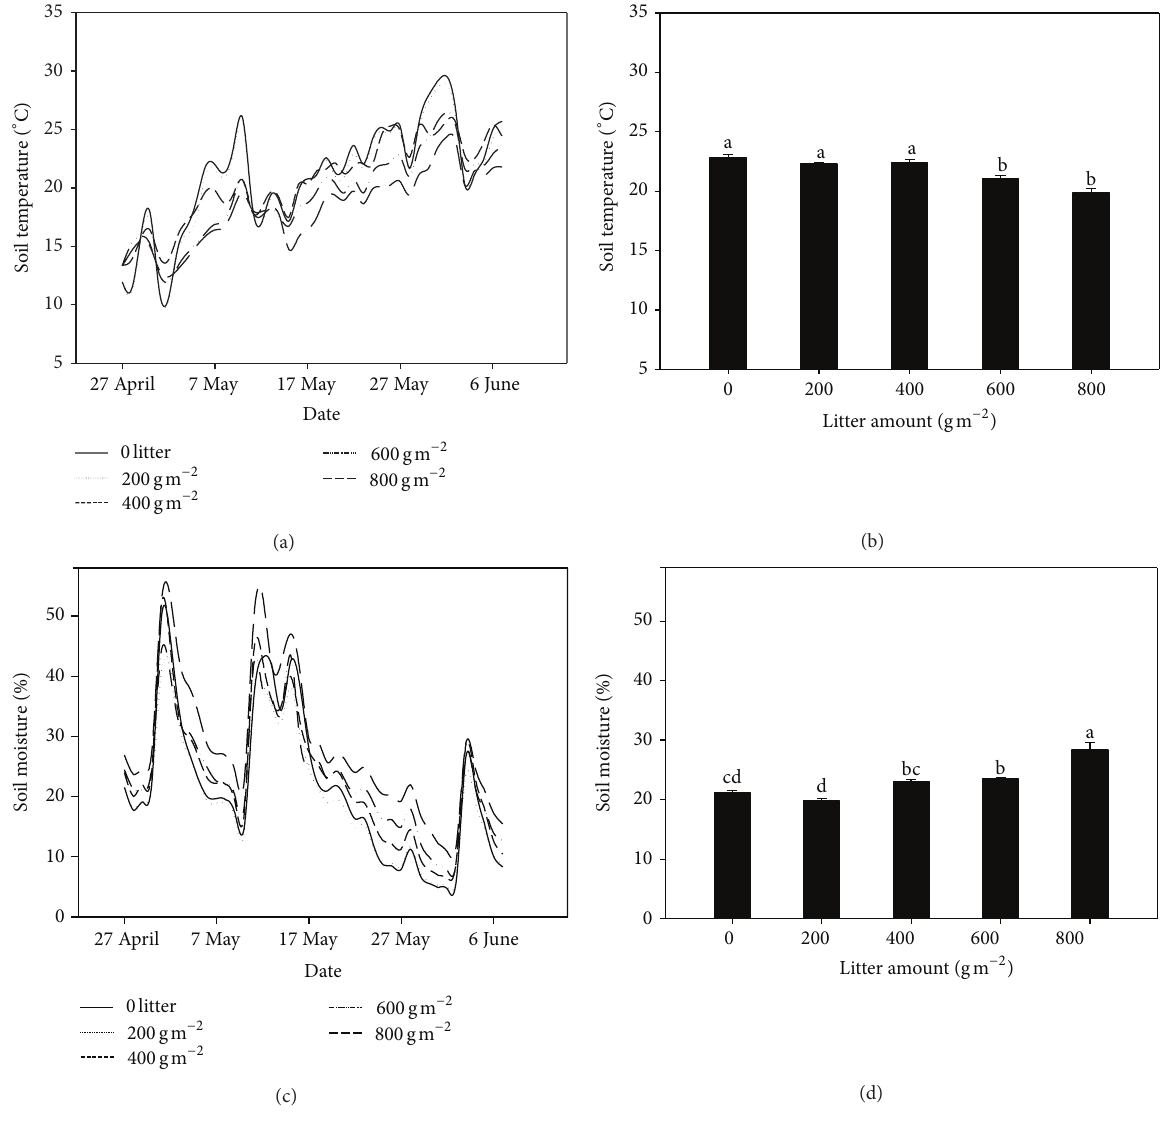
Figure 1: Soil temperature ((a) and (b)) and moisture ((c) and (d)) under different litter cover treatments. The lines represent the temporal dynamic of soil temperature and moisture; the bars with mean + SE represent mean soil temperature and moisture from 27 April 2011 to 7 June 2011; different letters indicate significant difference between treatments at 𝑃 < 0.05 .